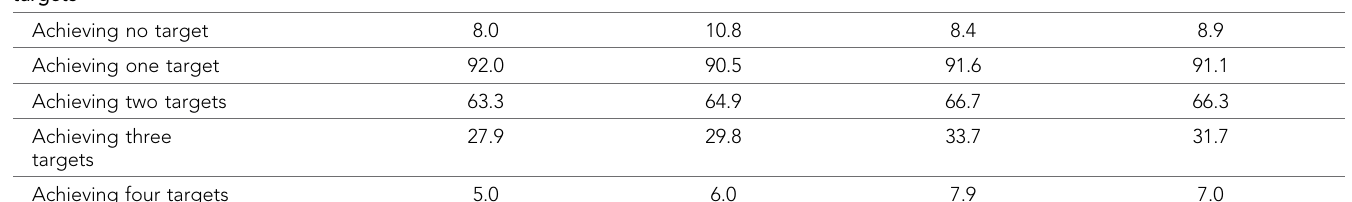
Significance tests used are c 2 tests for categorical variables. a Treatment targets for patients with CHD are: HbA1c <7.0%, SBP target <135 mmHg medicated or <140 mmHg unmedicated, LDL-cholesterol <1.8 mmol/l, no smoking. For patients without CHD, the intervention threshold for LDL-cholesterol are LDL >3.5 mmol/l,